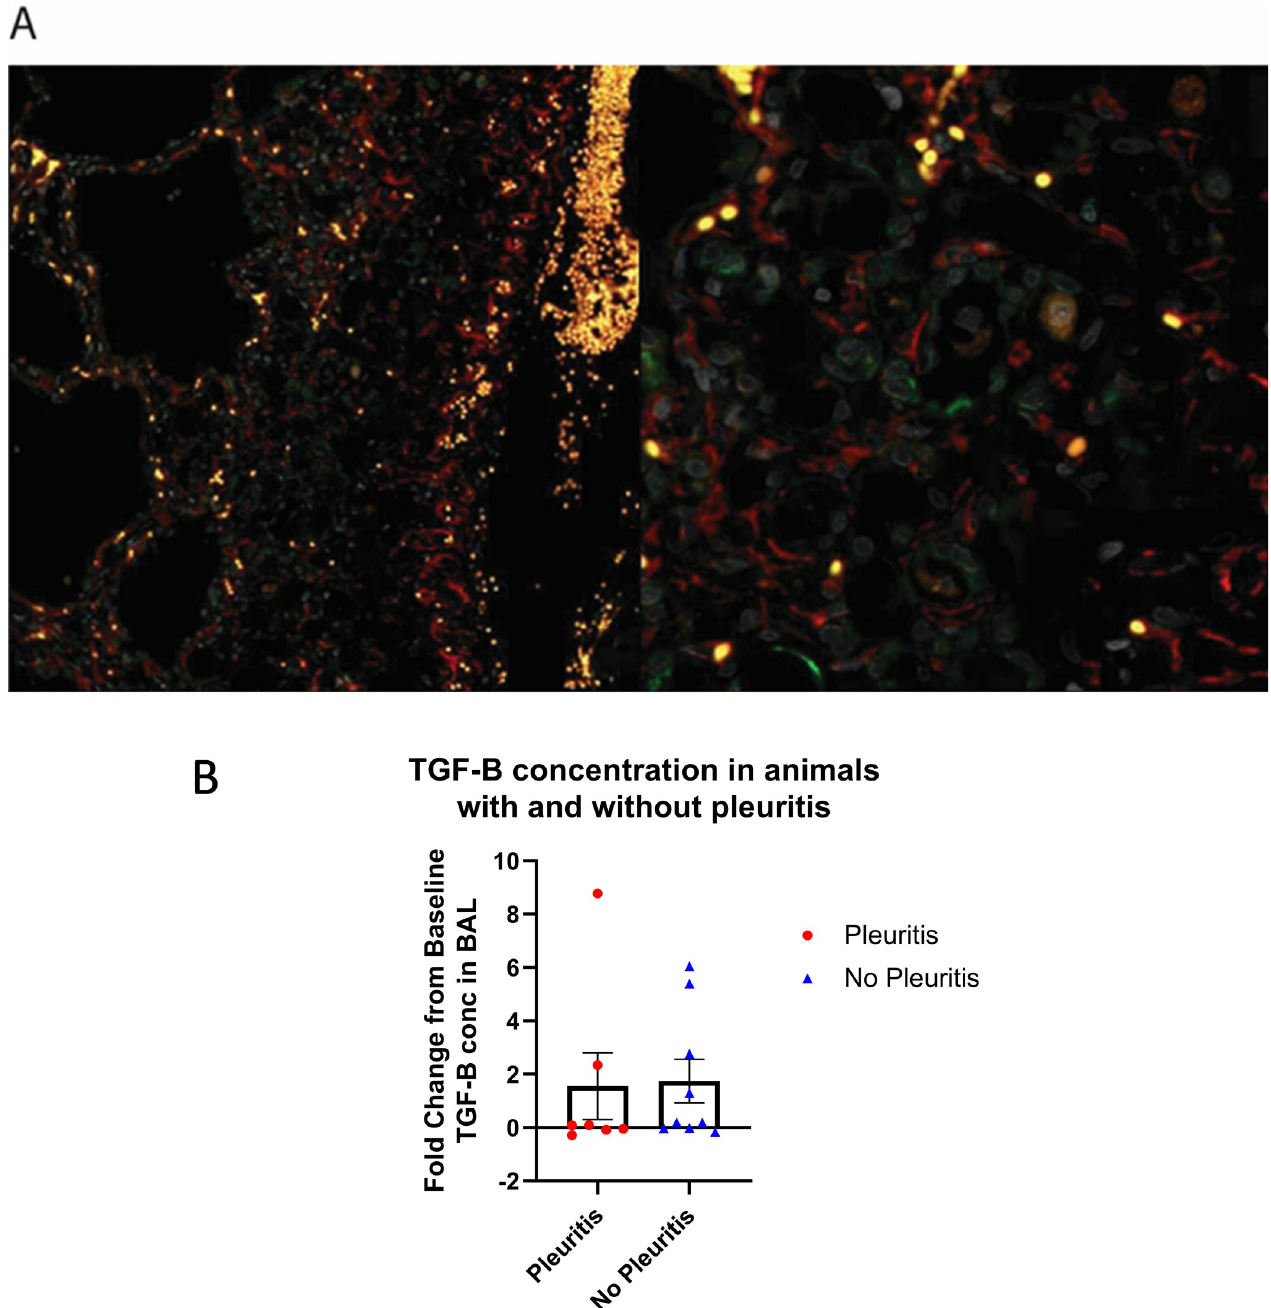
Fig 9. Activated myofibroblasts are present within scarred lung tissue and persist long term. A) KN90, lung alveoli. Myofibroblasts characterized by double-positive staining of α SMA (red) and cytokeratin 5 (green). Bar = 100 μ m. B) There was a > 2 fold increase above baseline in TGF-B concentration in BAL in five of sixteen animals. TGF-B concentration was not siginifcantly different between animals that developed